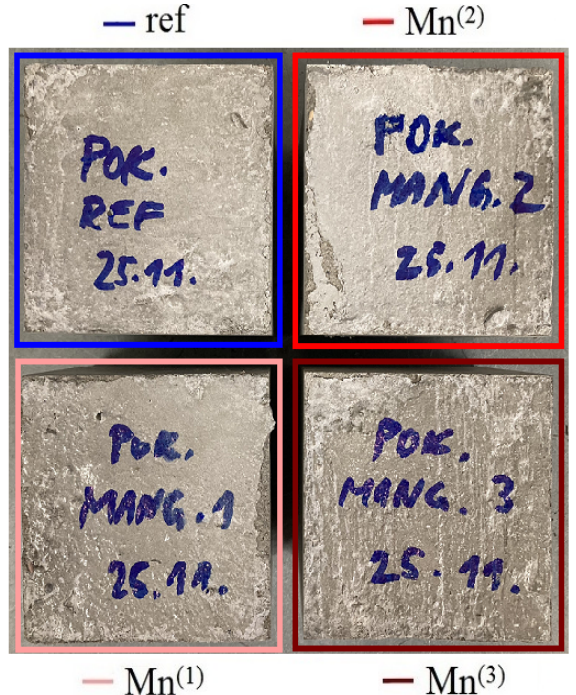
Figure 13. Appearance of homogeneous cube groups from concrete mixtures without (ref) and with MnO 4 − additions for compressive strength test.